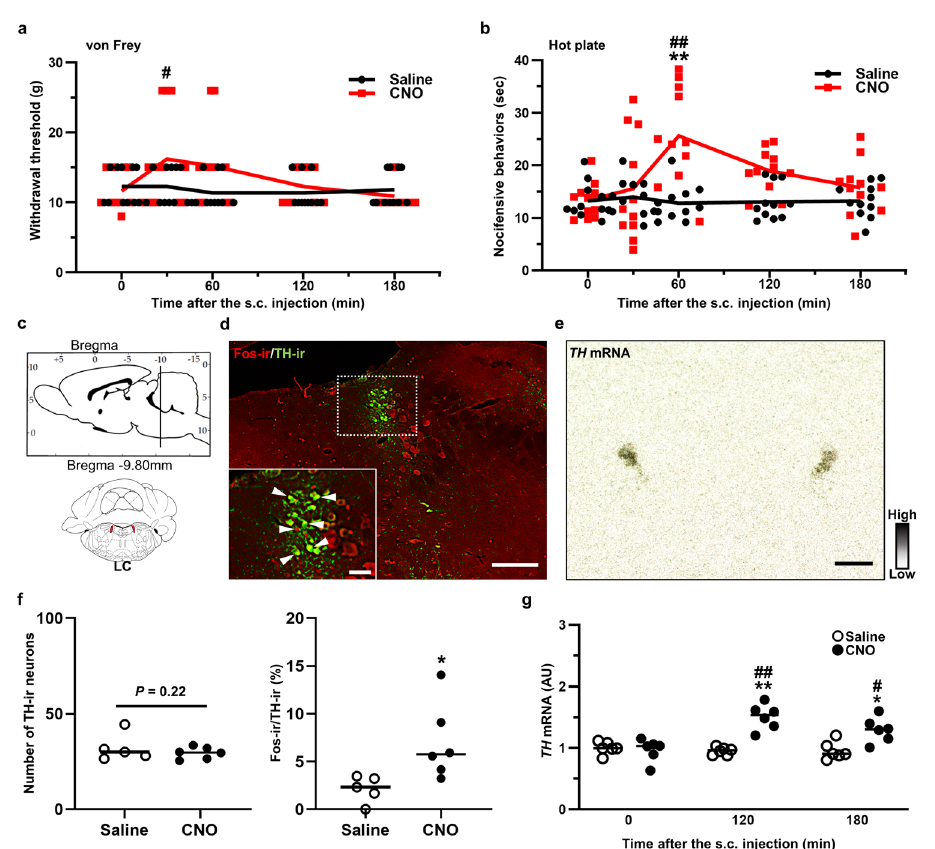
Fig. 3 OT altered nociceptive behavior and activated noradrenergic neurons in the LC. Results of manual von Frey ( a ) and hot plate tests ( b ). c Schematic illustration of the locus coeruleus (LC). d FIHC images of tyrosine hydroxylase (TH)-ir and Fos-ir in the LC at 120 min after the s.c. injection of CNO. e ISH image of TH in the LC. f Number of TH-ir neurons and percentage of Fos-ir neurons in TH-ir neurons in the LC ( n = 10 – 12 slices from 5 to 6 rats, each). g Gene expression of TH in the LC after the s.c. injection of Saline or CNO (1 mg kg − 1 ) ( n = 12 slices from 6 rats, each). Scale bars, 200 μ m. Data are represented as mean ± SEM. * P < 0.05; ** P < 0.01 vs. Saline. # P < 0.01; ## P < 0.01 vs. CNO at 0 min. See also Supplementary Figs. 3,